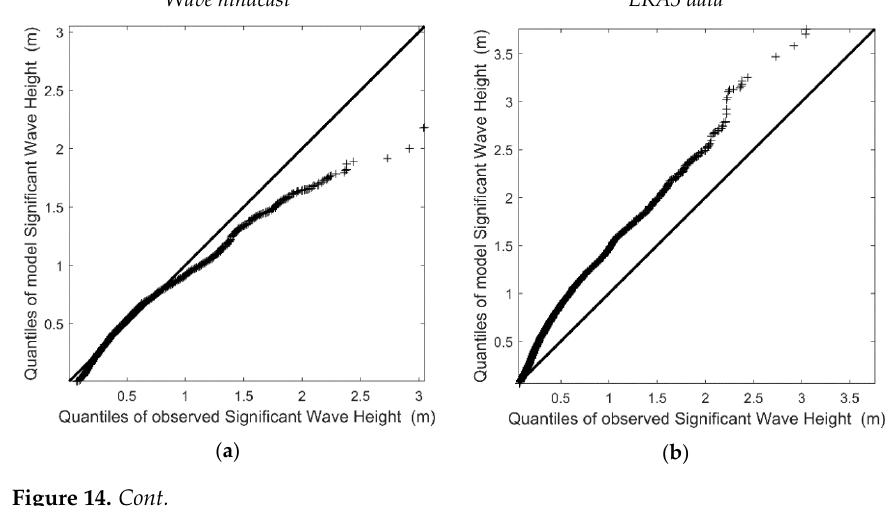
Figure 13. Wave roses of Hs and Dirm for: ( a ) Bastia (no. 3) buoy; ( b ) Bastia wave hindcast point; ( c ) Bastia ERA5 point; ( d ) Capo Mele (no. 5) buoy; ( e ) Capo Mele wave hindcast point; ( f ) Capo Mele ERA5 point. Wave roses of Hs and Dirp for: ( g ) Castiglione (no. 6) buoy; ( h ) Castiglione wave hindcast point; ( i ) Giannutri (no. 8) buoy; ( j ) Giannutri wave hindcast point.